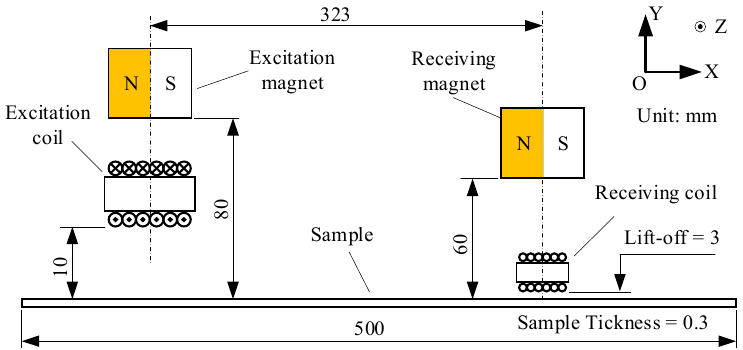
Figure 7. Schematic diagram of the experiment configuration.